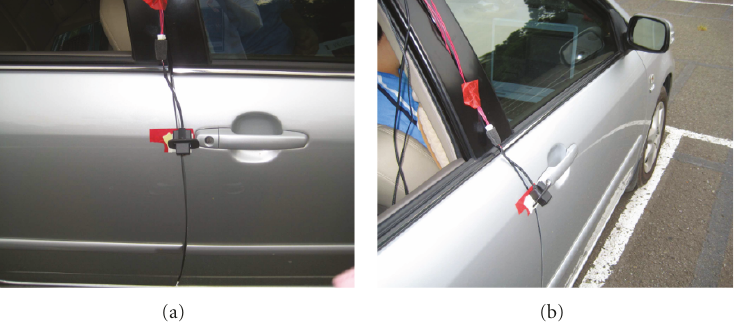
Figure 20: The setup locations of